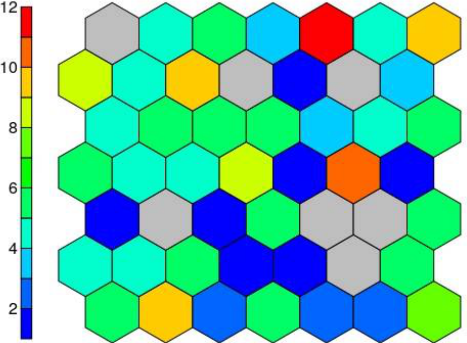
Figure 8. Number of cases on each neuron.